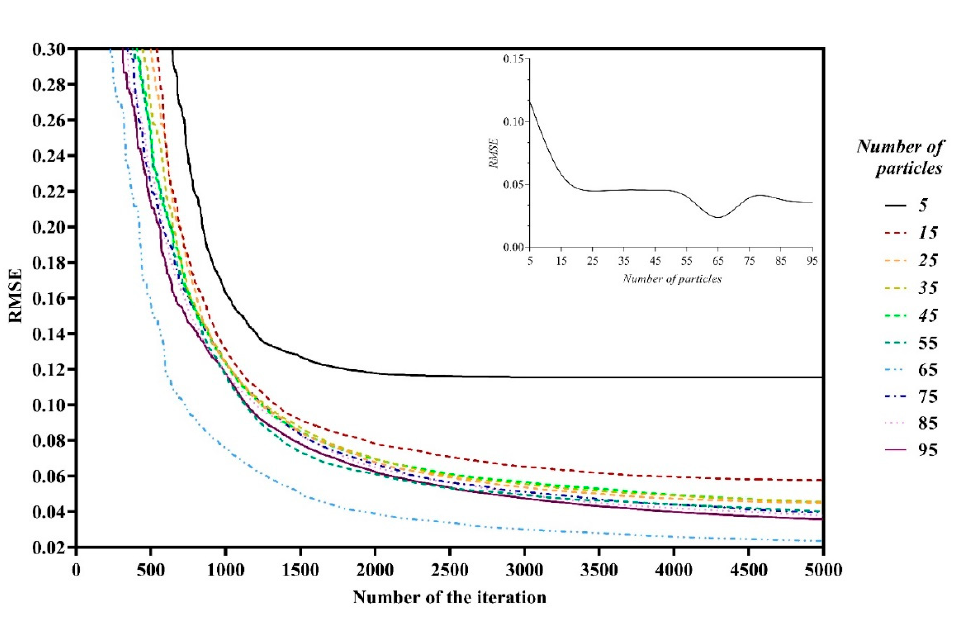
Figure 11. ANFIS-PSO: evolution of the RMSE during the optimization by PSO, as a function of the number of particles.